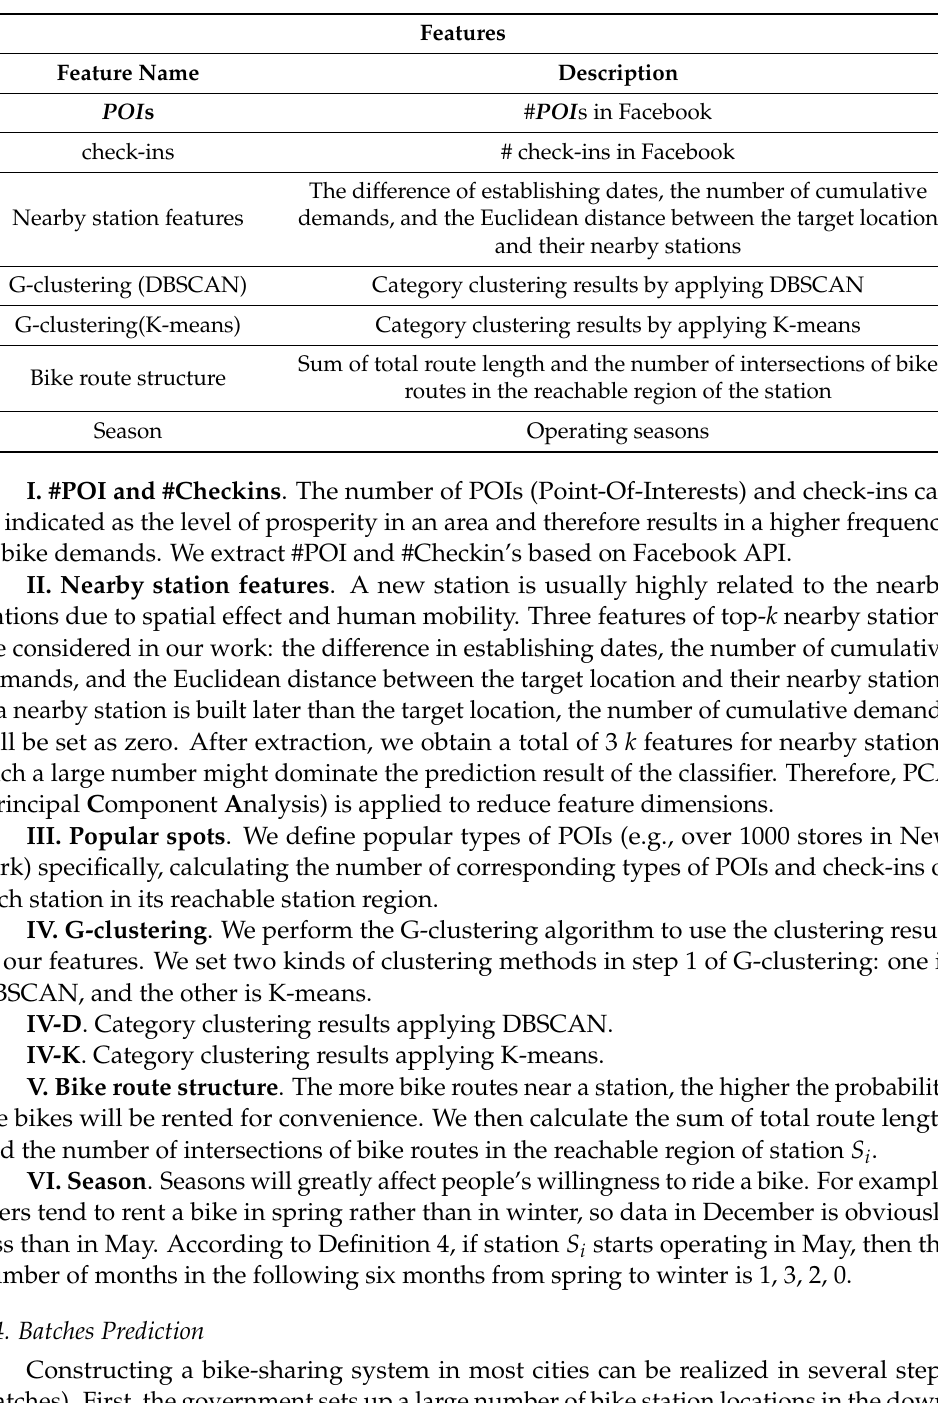
Table 3. All Features and their